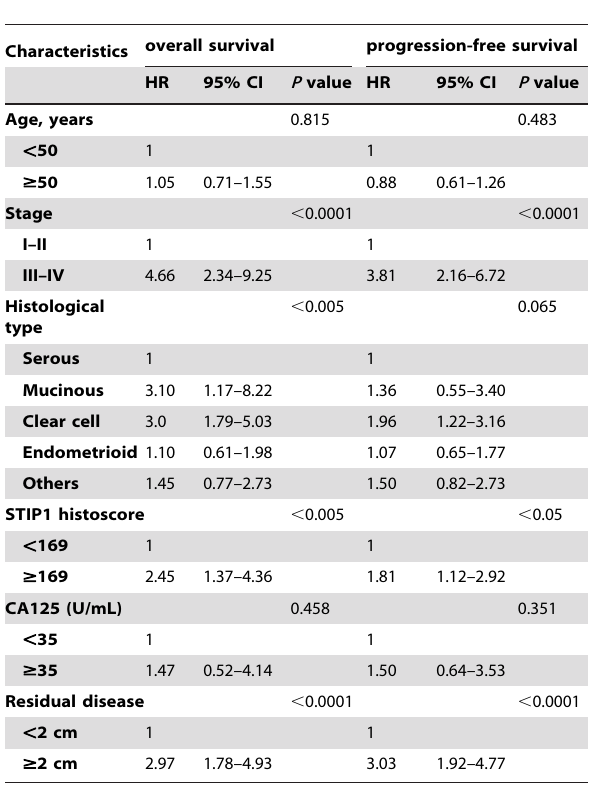
Table 2. Multivariate analyses of clinicopathological parameters for overall and progression-free